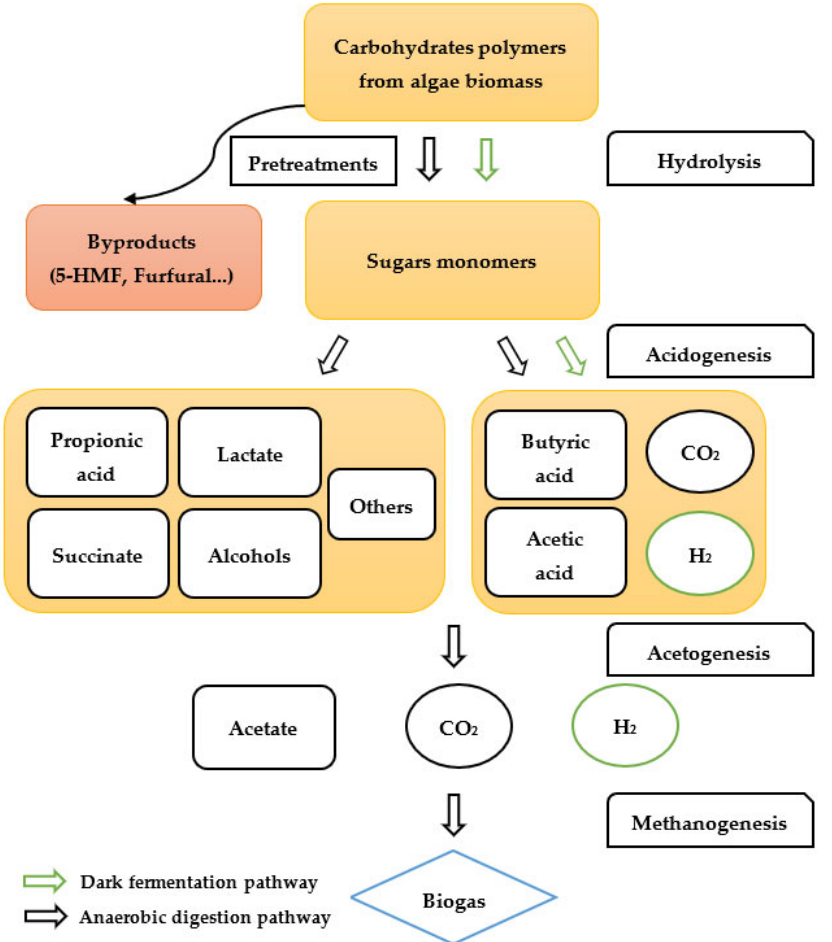
Figure 8. Scheme of carbohydrate polymers degradation through dark fermentation and AD bioprocesses (adapted from [47,86,154–156]).